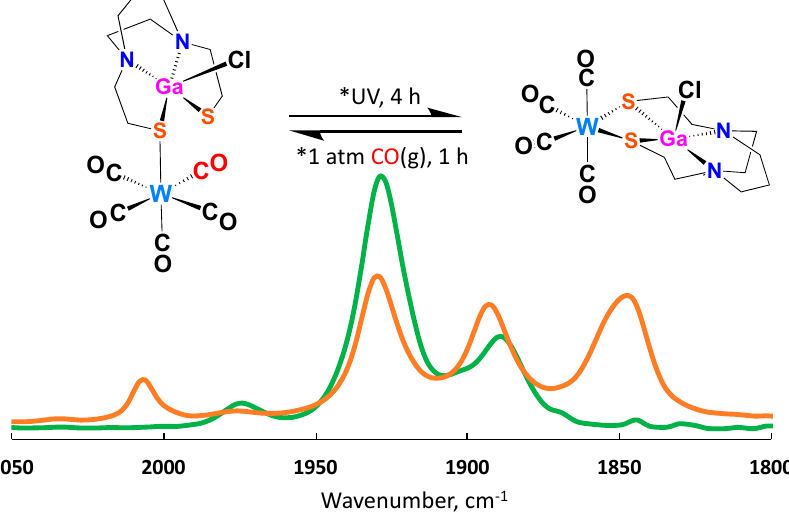
Figure 7. Reactions of ClGaN 2 S 2 ·W(CO) 5 and ClGaN 2 S 2 ·W(CO) 4 under UV light